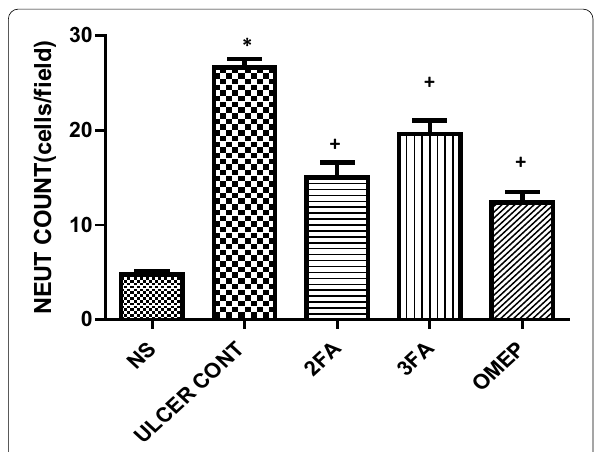
Fig. 2 Neutrophil count in the stomach of rats treated with varying doses of folic acid and Omeprazole after pyloric ligation ulcer. (* p < 0.05 ulcer control cf. control; + p < 0.05 cf. ulcer control). NEUT COUNT, Neutrophil Count. NS Normal stomach, ULCER = CONT